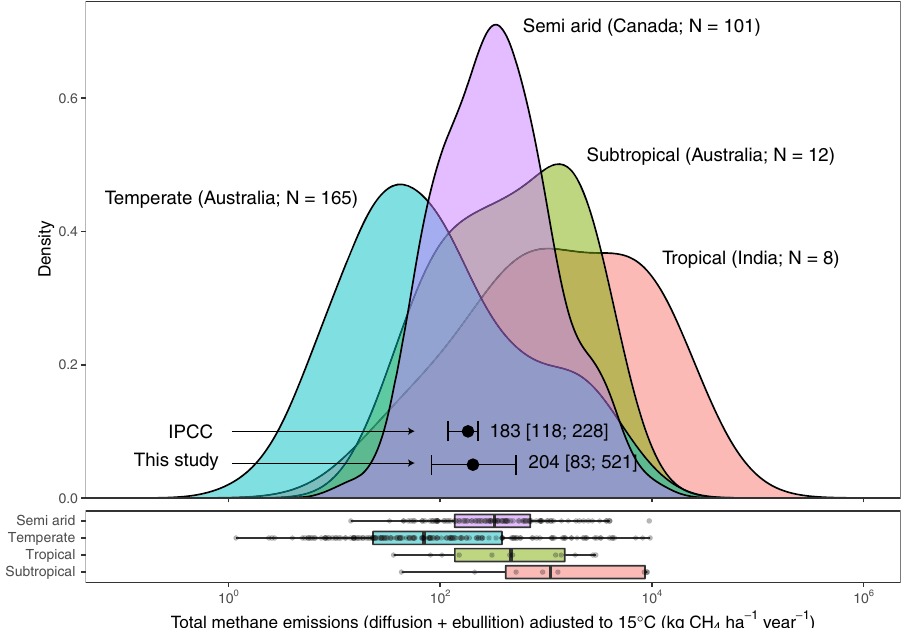
Fig. 2 Meta-analysis on total methane emissions (diffusion + ebullition) from agricultural ponds. We compiled values from the scienti fi c literature, supplemented with new data from 11 sites in temperate Australia (see labels for sample size; N ). We standardised all rates to 15 °C (using Eq. 1 and Fig. S2) and accounted for ebullition and diffusion (using Fig. S3). The colours of the density functions indicate the climate. Black points indicate either the IPCC emission factor recommended for constructed waterbodies across all climates (Table 7.12 in Lovelock et al. 14 ), or the geometric mean calculated from all data compiled in this study — with error bars representing the 95% con fi dence intervals. Box-and-whiskers show the distribution of the compiled data divided by